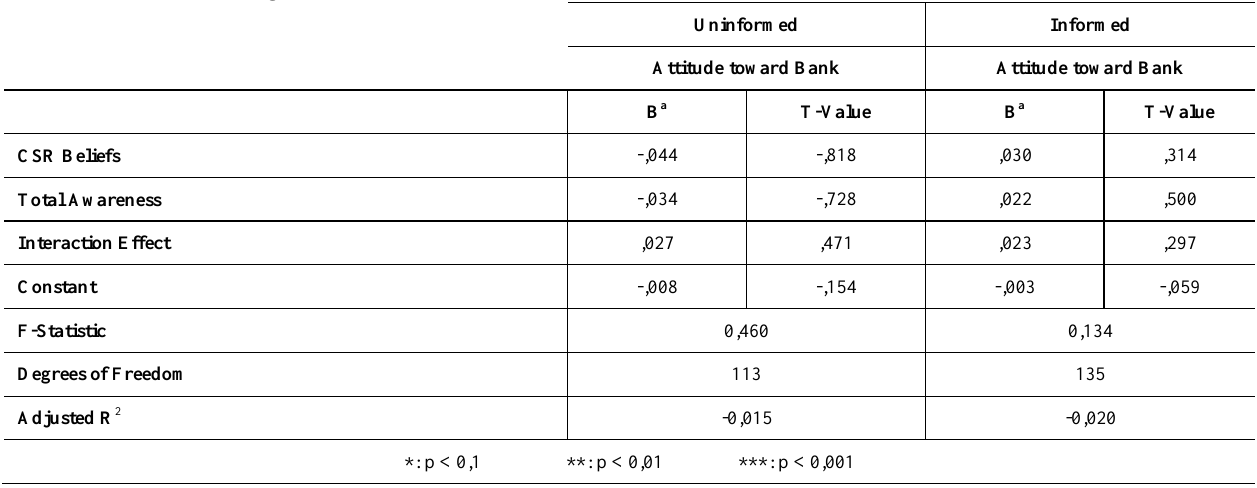
Table 5: Moderation regression statistics